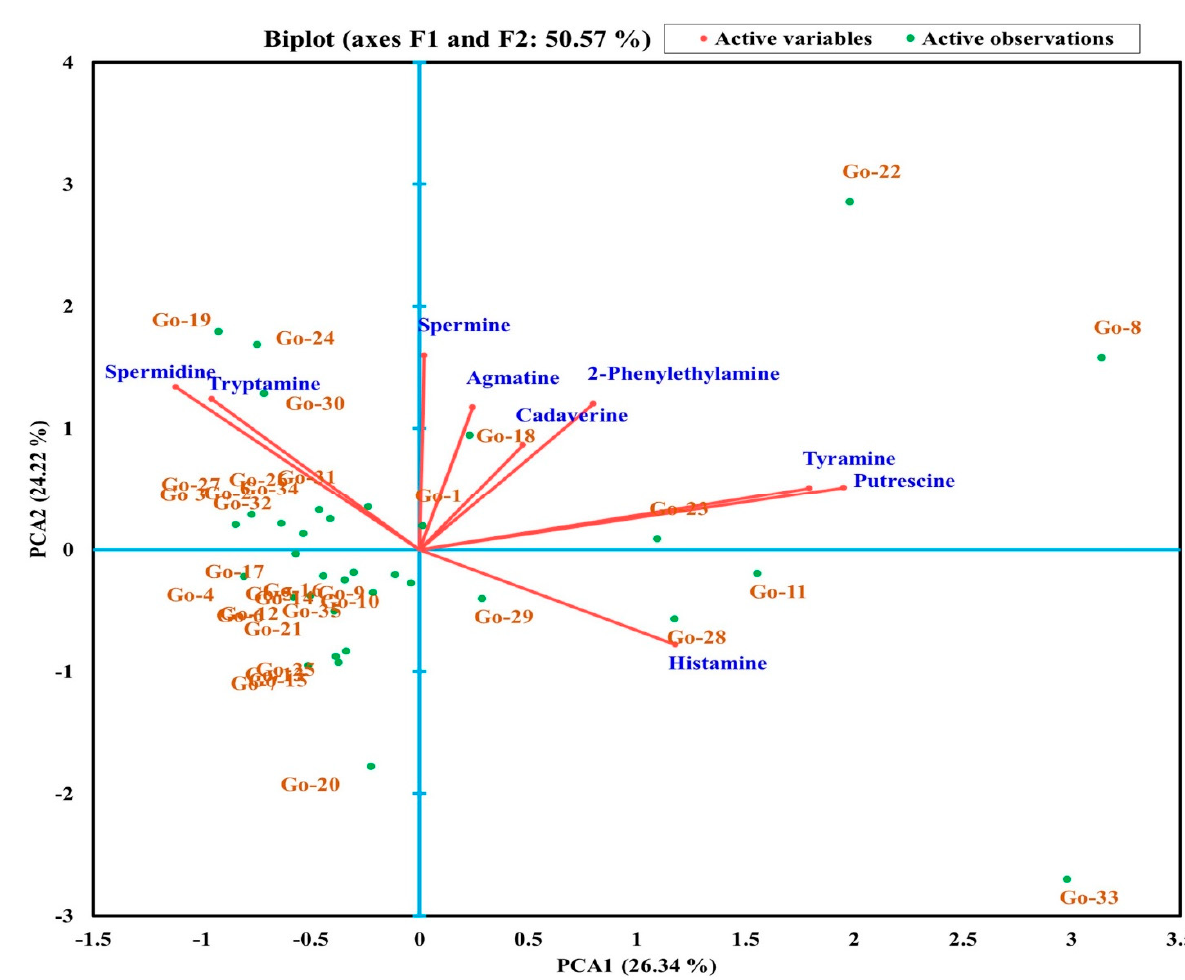
Figure 3. Principal component analysis of biogenic amines in different gochujang products from the traditional cottage industry.